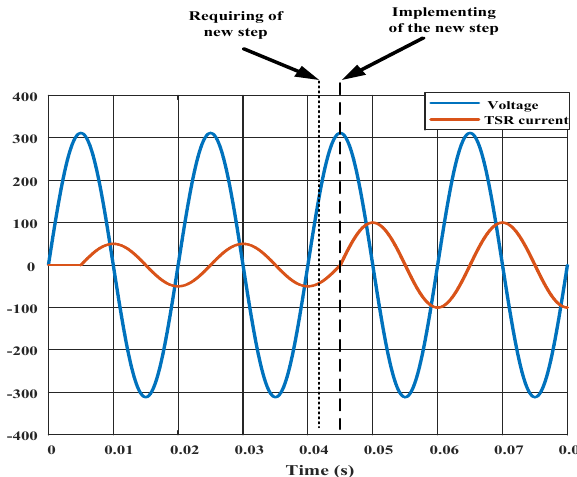
Fig. 7. TSR voltage and current waveforms during transition from one step to another